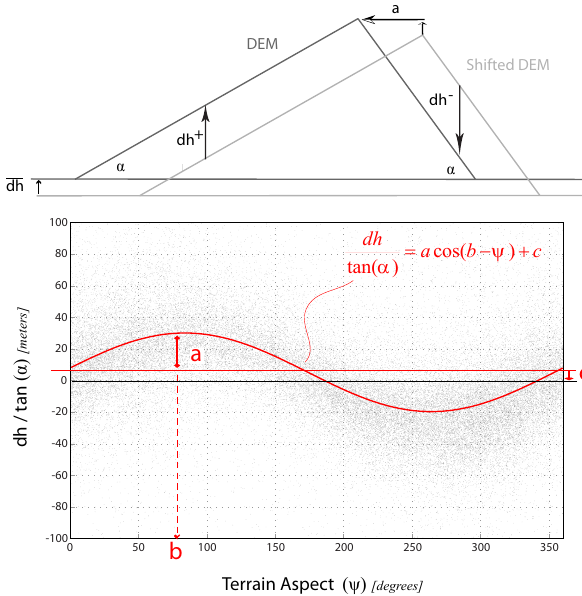
Fig. 2. Top: 2-D scheme of elevation differences induced by a DEM shift. Bottom: The scatter of elevation differences between 2 DEMs showing the relationship between the vertical deviations normalized by the slope tangent (y-axis) and terrain aspect (x-axis). The exam- ple is the DEM differences between the 2002 and 2003 DEM shown in Sect. 5. The equation for the solved sinusoidal curve fit is shown along with the three unknown solution parameters, a , b and c